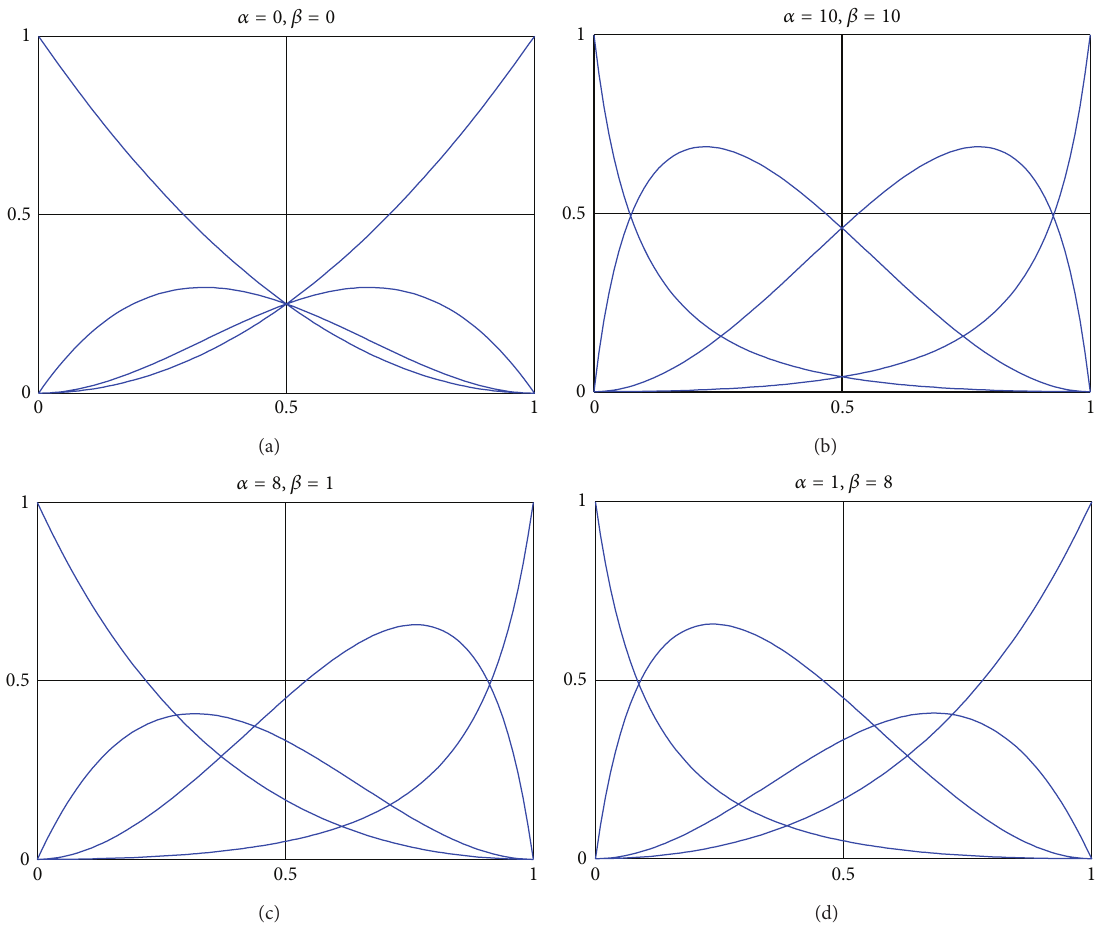
Figure 1: Some plots of the new quartic rational Said-Ball-like basis